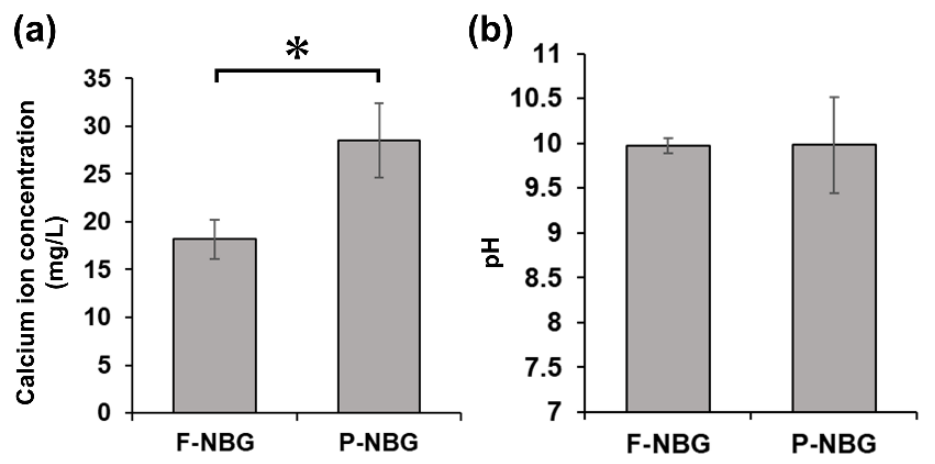
Figure 4. Calcium ion concentrations ( a ) and pH levels ( b ) of distilled water after immersion of flowable and putty-form Nishika Canal Sealer BG Multi (F-NBG and P-NBG). Asterisk indicates p < 0.05 (unpaired t -test, n = 6).